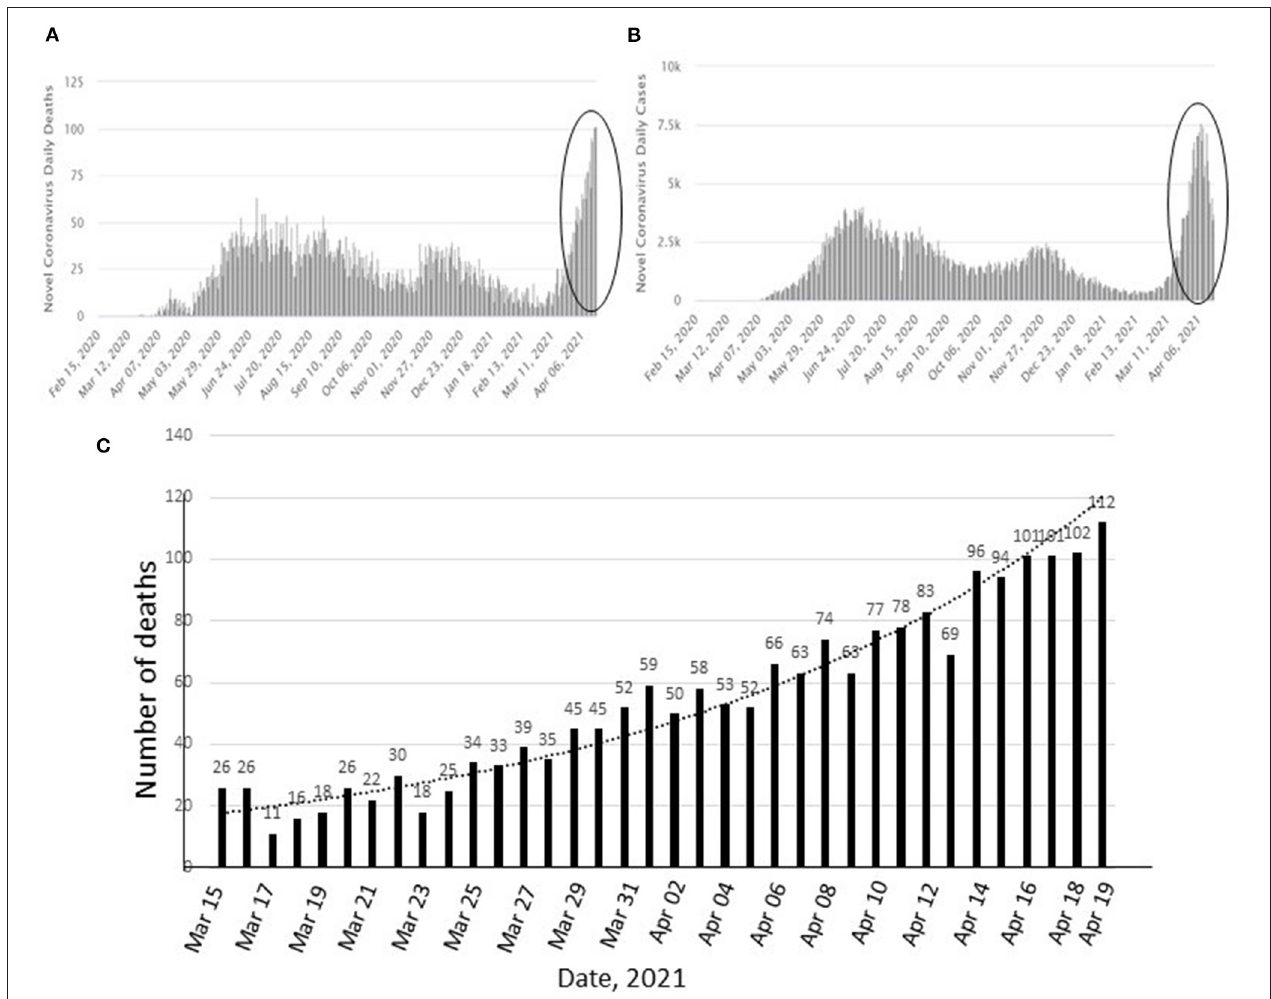
FIGURE 1 | Changes in positive cases and deaths by COVID-19 in Bangladesh since March 2020 to April 19, 2021 (A,B) . Circles show the recent upsurge. Increase in number of deaths during March 15 to April 19, 2021 (C) . (A,B) : source: https://covid19.who.int/region/searo/country/bd, (accessed April 19,